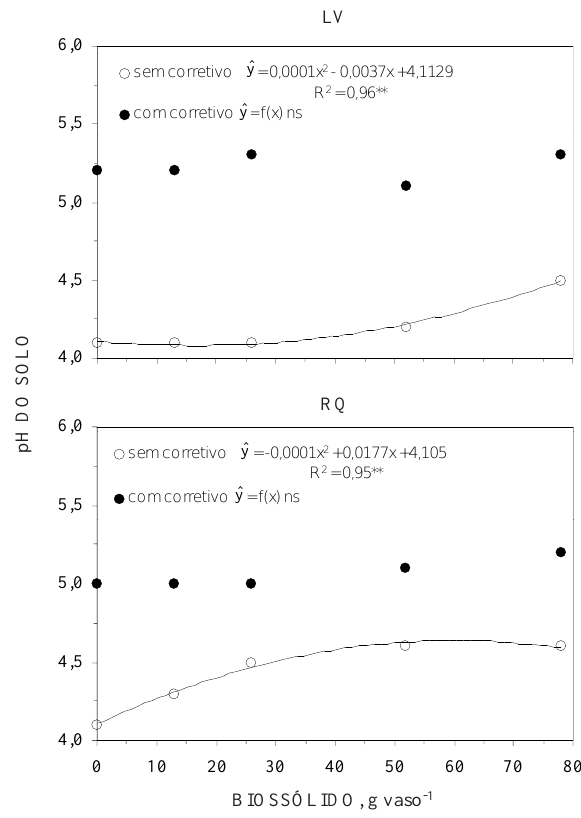
Figura 2. Valores de pH do solo, considerando a aplicação de